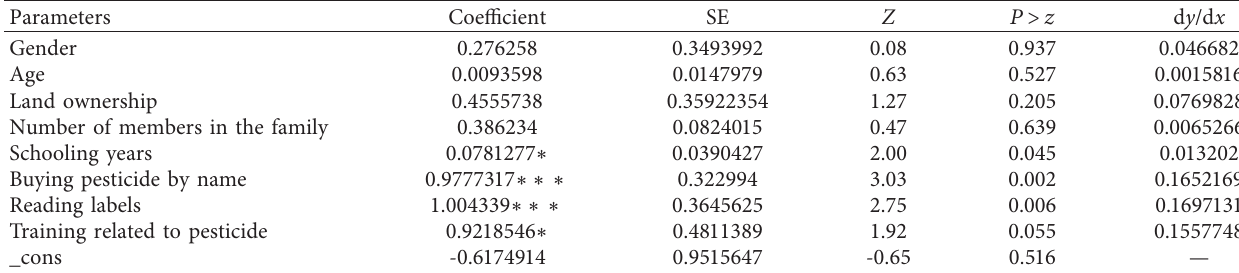
Table 6: Factors influencing the awareness of the use of